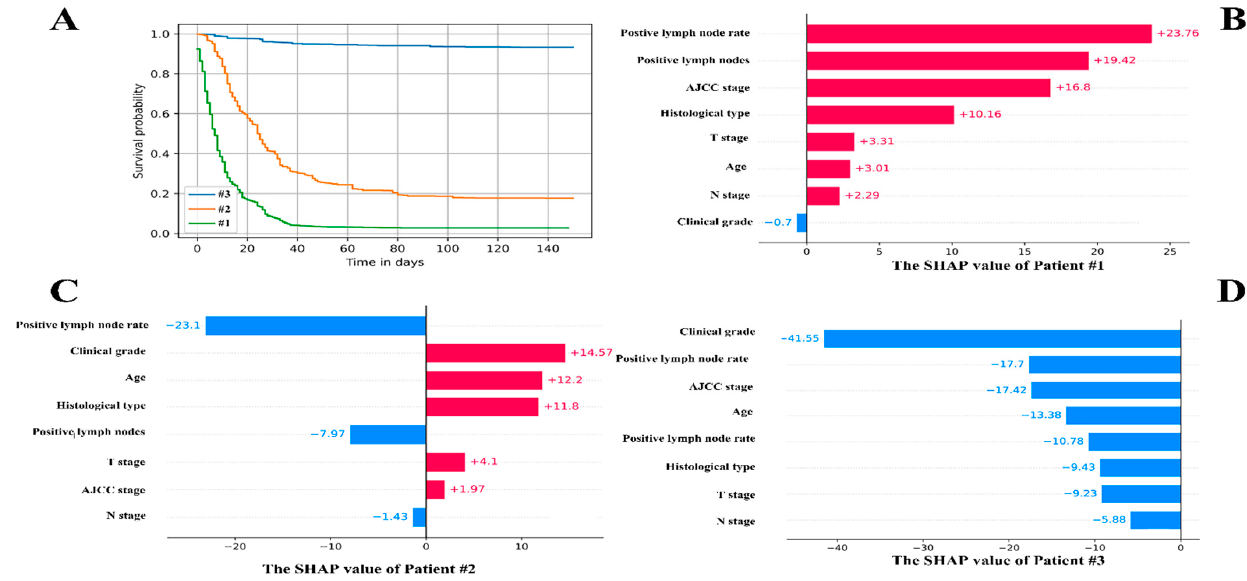
Figure 6. The individual postoperative prognostic prediction. ( A ). The estimated survival function of patients. The green line symbolizes the patients A while the yellow line represents the patient B. The blue line on behalf of the patient C. ( B ). The local SHAP plot of the patient #1. ( C ). The local SHAP plot of the patient #2. ( D ). The local SHAP plot of the patient #3. The red ribbon in the local SHAP plot represented the risk factors, which promoted the poor prognosis, whereas the blue ribbon was the relatively protective factors.